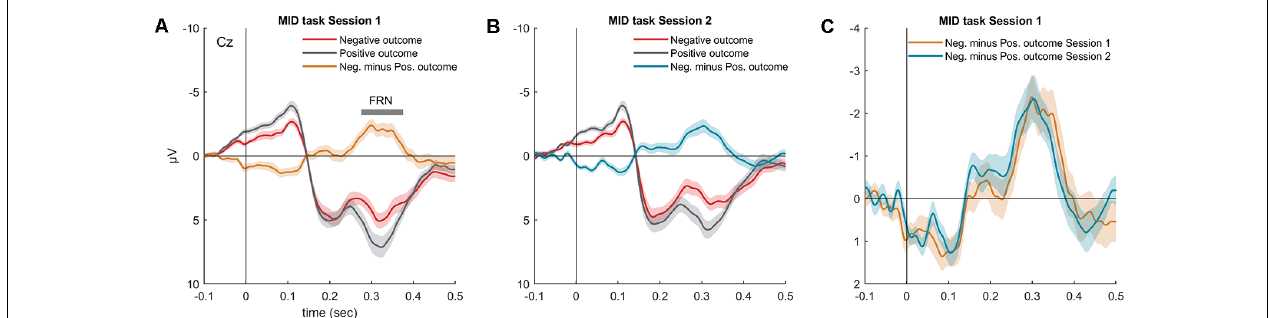
FIGURE 3 | Grand-averaged visual ERP waveforms (Cz) superimposed for the outcomes with different valences (negative outcome, positive outcome) and the difference waveform recorded during the MID task (A) session 1 and (B) session 2. (C) Superimposed difference waveform (Cz, negative minus positive outcomes) for two sessions of the MID task. Shaded area around curves represents SEM.